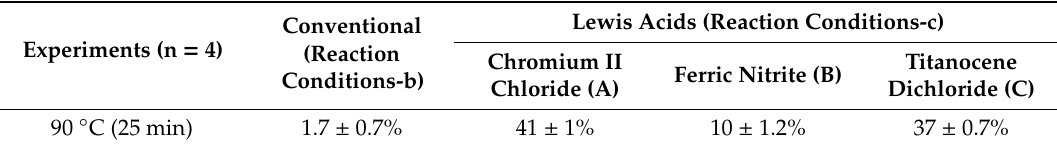
Table 1. Comparison of radiochemical yields (RCYs) via different methodologies (Figure 2A). Lewis Acids (Reaction Conditions-c) Conventional Experiments (n = 4) (Reaction Chromium II Titanocene Conditions-b) Chloride (A) Dichloride (C) Ferric Nitrite (B) 90 °C (25 min) 1.7 ± 0.7% 41 ± 1% 10 ± 1.2% 37 ± 0.7%